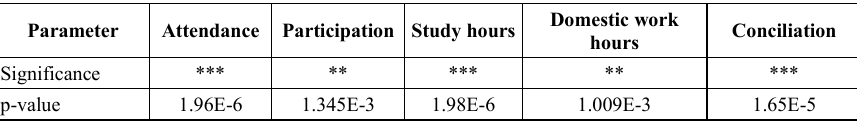
Table 4. Academic performance comparison: gender gap in the